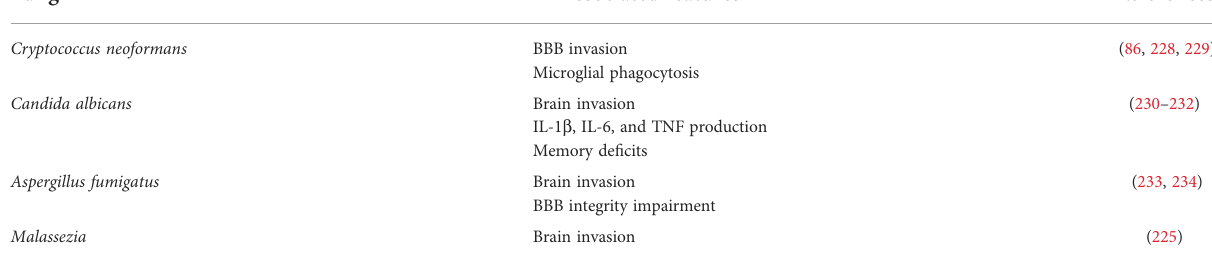
TABLE 3 Association of fungal infection and neurological